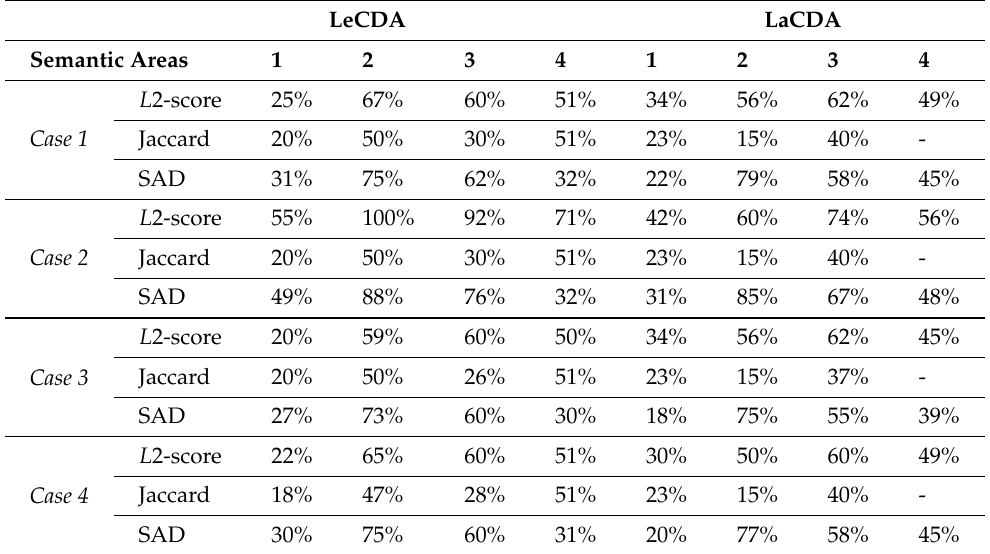
Table 1. Comparative accuracy (%) results of clustered ground-truth images in each semantic area for different experimental set-ups in Case 1, Case 2, Case 3 and Case 4 . Table entries marked with “-” correspond to communities that are not detected. The higher performance rates are represented in bold.